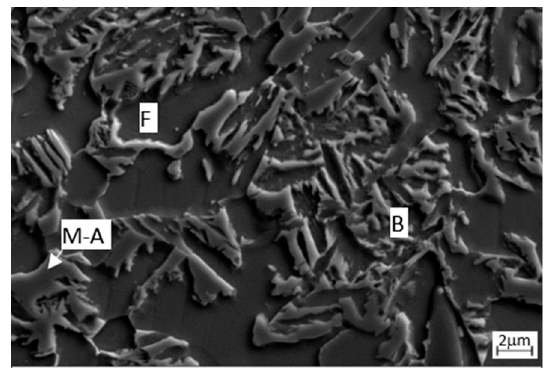
Figure 3. Heat treatment parameters: Soaking 850 °C/100 s, cooling rate 30 °C/s, bainitic hold 400 °C/600 s. Ferritic-bainitic microstructure with M-A constituent.